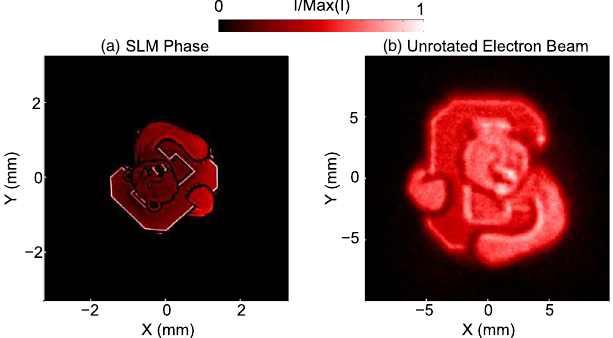
FIG. 9. (a) Phase applied to the SLM to create the shape in (b). The phase ranges from ½ 0 ; π (cid:2) . (b) Electron beam distribution created with electron beam feedback, which does not directly profile the laser. The target distribution is that of Fig. 6(a), scaled by the electron magnification.